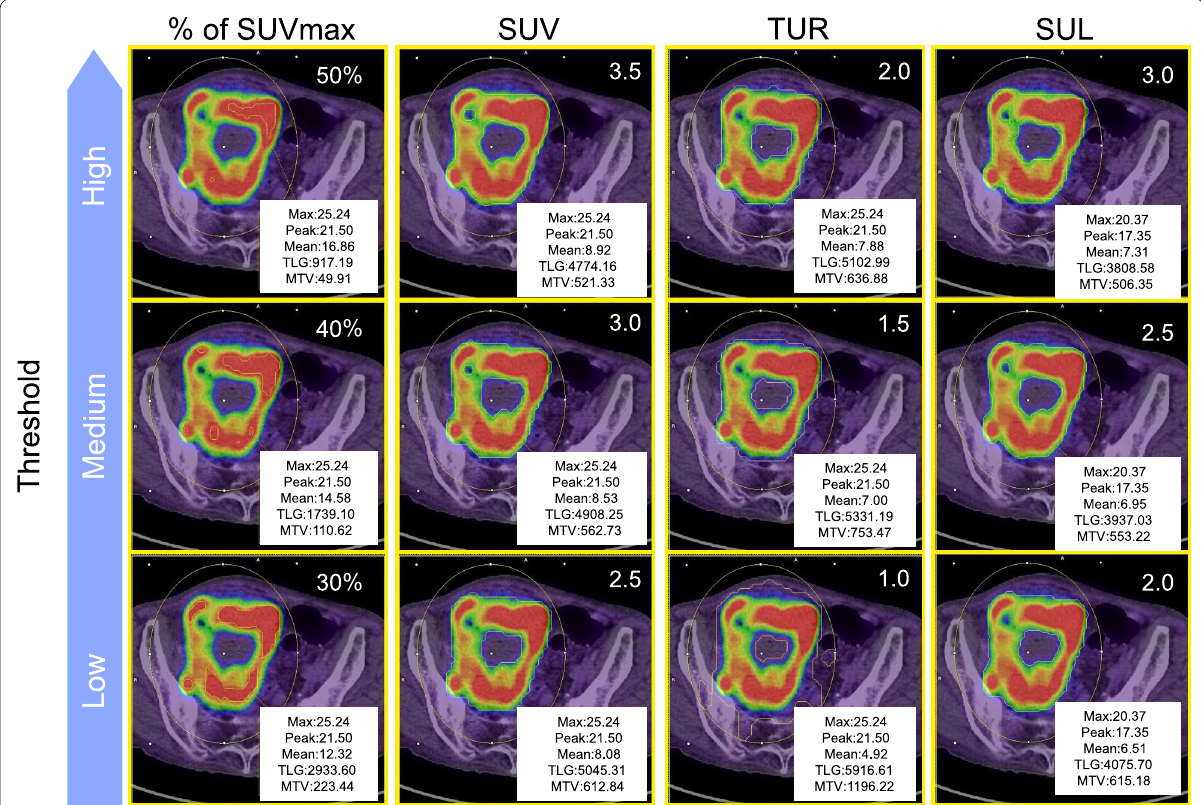
Fig. 1 Thresholds in case of a higher SUVmax tumor. SUVmax, maximal standardized uptake value; SUV peak, peak standardized uptake value; SUV, mean standardized uptake value; MTV, metabolic tumor volume; TLG, total lesion glycolysis; TUR, tumor-to-liver uptake ratio; SUL, SUV normalized to lean body mass; VOI: volume of interest. VOIs in % of SUVmax were smaller than in other thresholds. For each threshold, the lower the value, the larger the